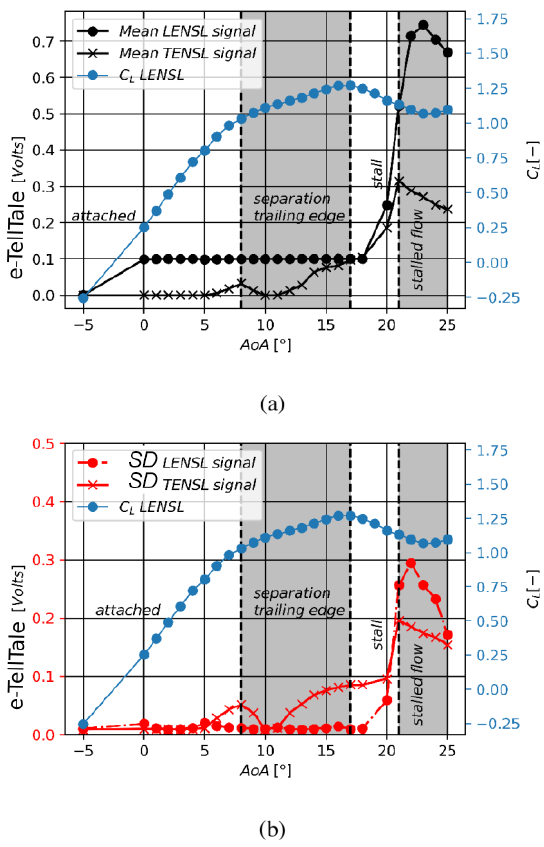
Figure 12. Comparison of the mean (a) and the standard devia- tion (b) of the signal of the LENSL and TENSL (reference case) e-TellTale sensors as a function of